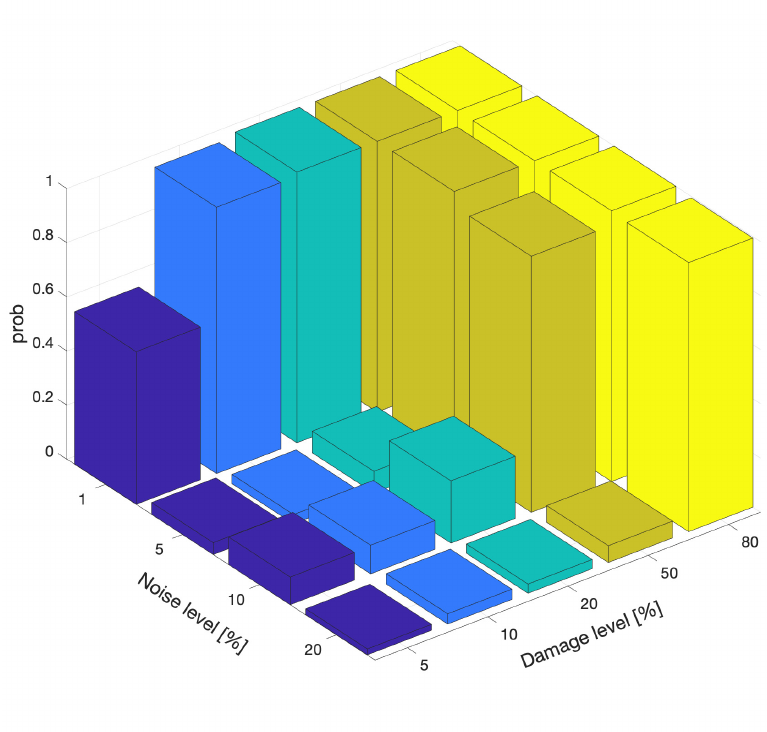
Figure 11. Effect of noise on probability of detecting damage at the abutment using modal curvature damage